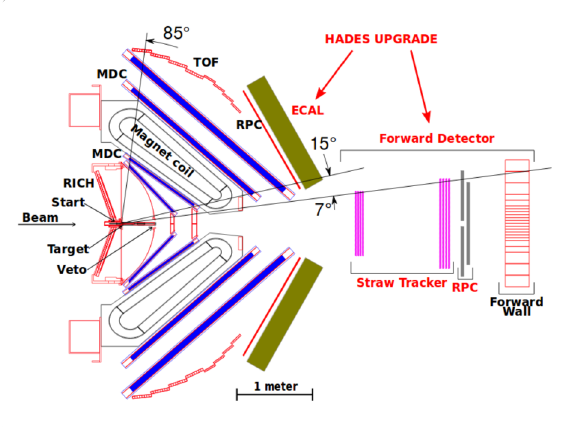
Figure 1. A sketch of the HADES detector (a side view in a vertical plane). The ongoing upgrades are labeled by read captions.